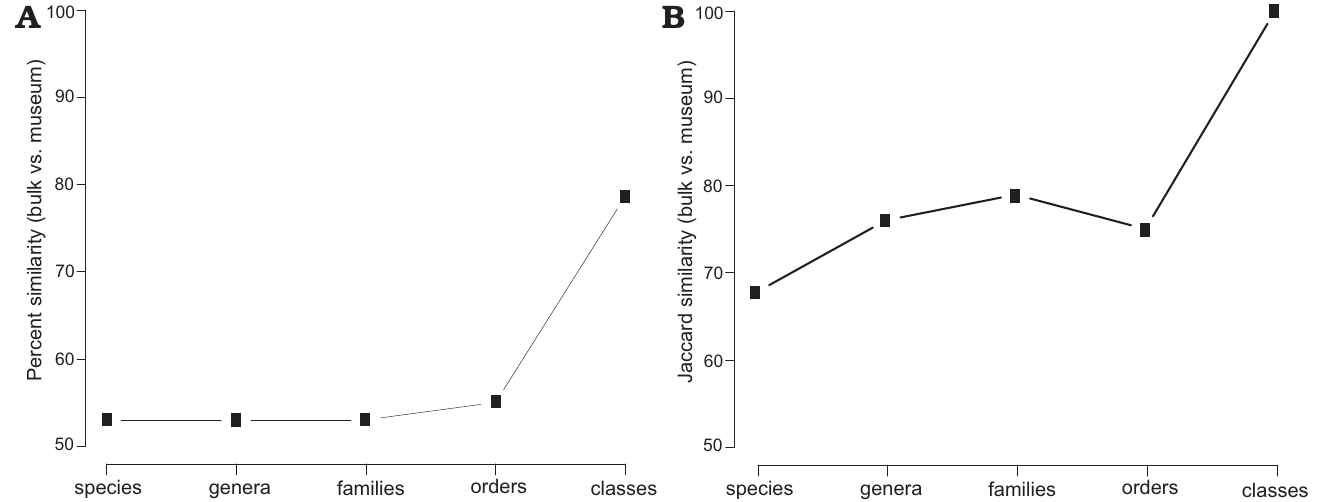
Fig. 10. Percent similarity ( A ) and Jaccard similarity ( B ) measurements between bulk and museum collection material at different taxonomic levels.